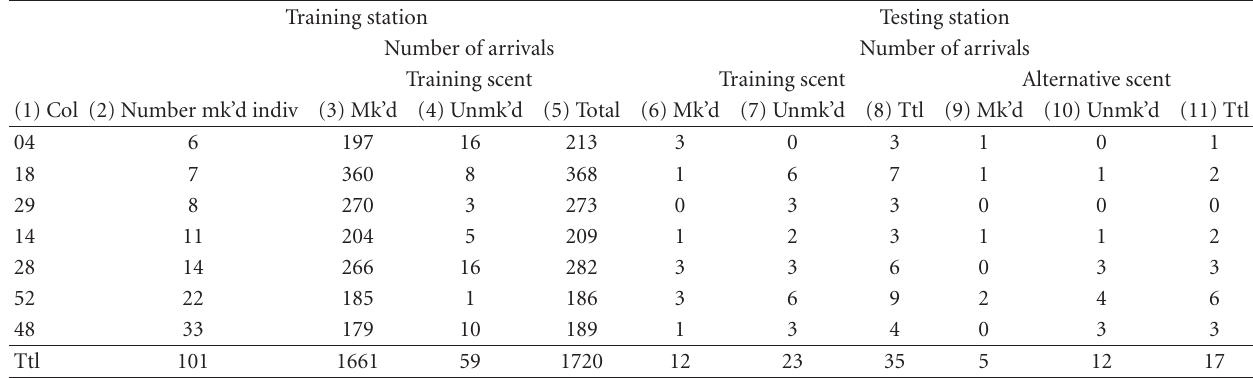
Table 2: Arrivals at the training and testing stations during the pretesting and testing phases. Column 2: number of marked foragers making one or more trips to the training station. Columns 3–11: numbers of arrivals. Only the marked foragers visiting the training station (column 3) were allowed to make repeated visits. All others were captured and held on ice upon arrival; therefore, columns 4 and 6–11 represent both numbers of arrivals and numbers of individuals arriving.